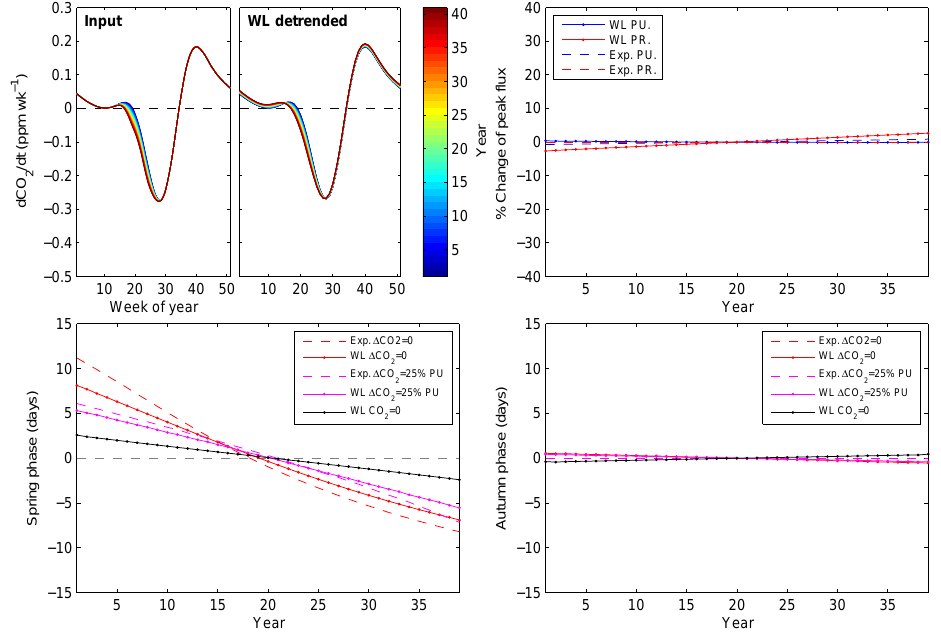
Figure B2. Wavelet analysis of (cid:49) t CO 2 flux time series including a prescribed earlier onset of net CO 2 uptake. Top left panel: the defined flux time series and the associated detrended time series. Top right panel: the expected (defined) and actual change in peak uptake and release of CO 2 . Bottom panels: the expected (defined) and actual change in (left) DZCP and (right) UZCP, including an operational version of the phase metric as described in the main